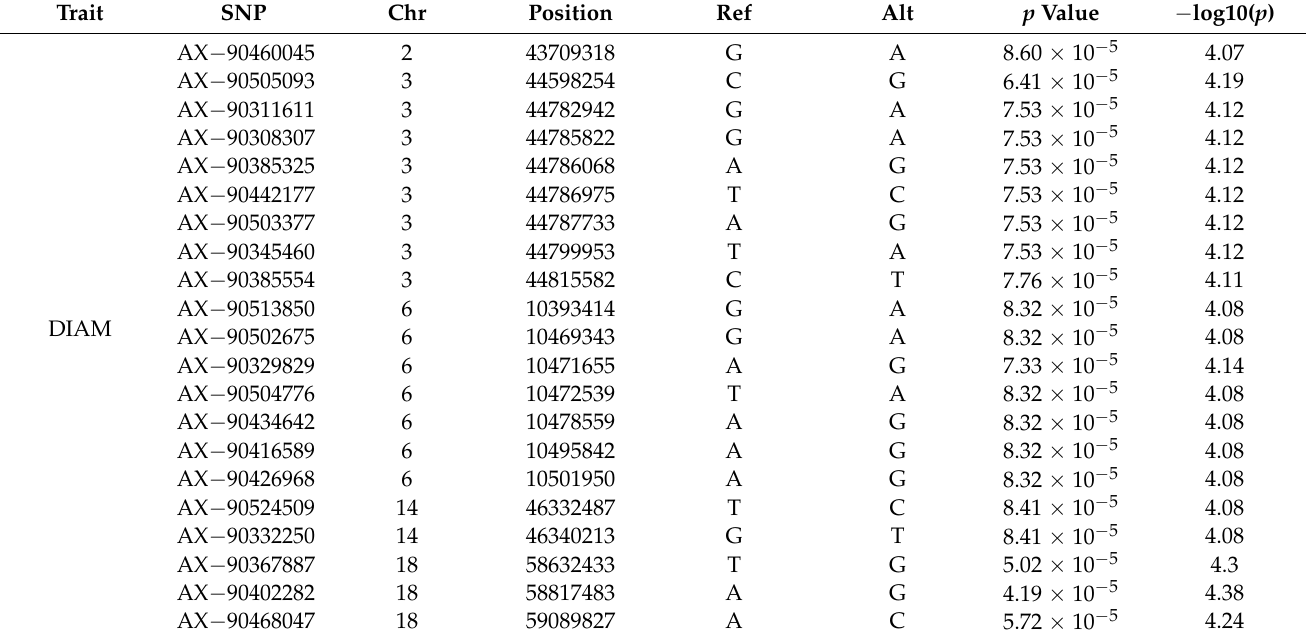
Table 1. Significant SNPs identified for root traits using the MLM model.